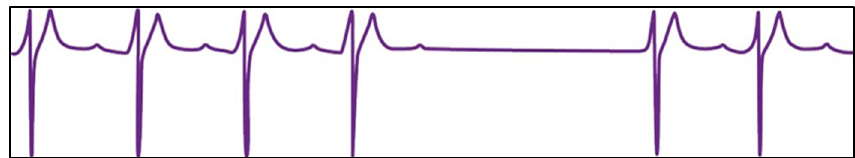
Figure 3. Collective anomalies .